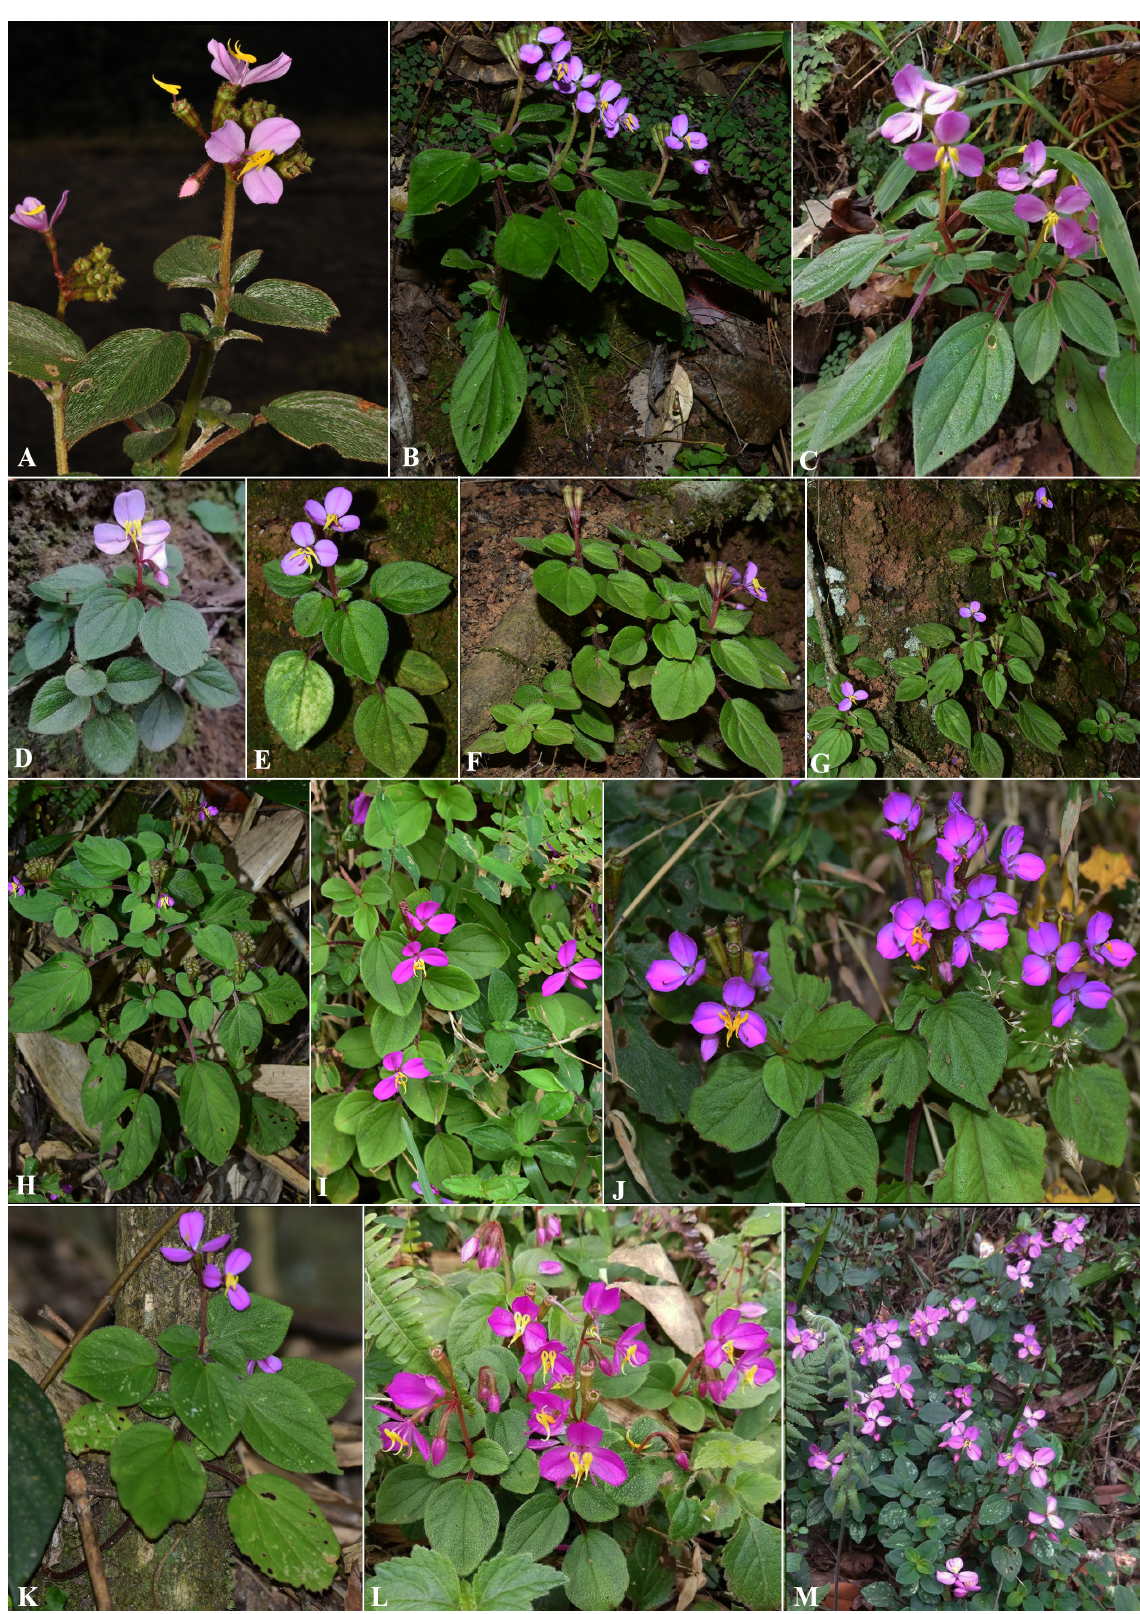
Fig. 5. Sonerila travancorica Bedd.; variations in